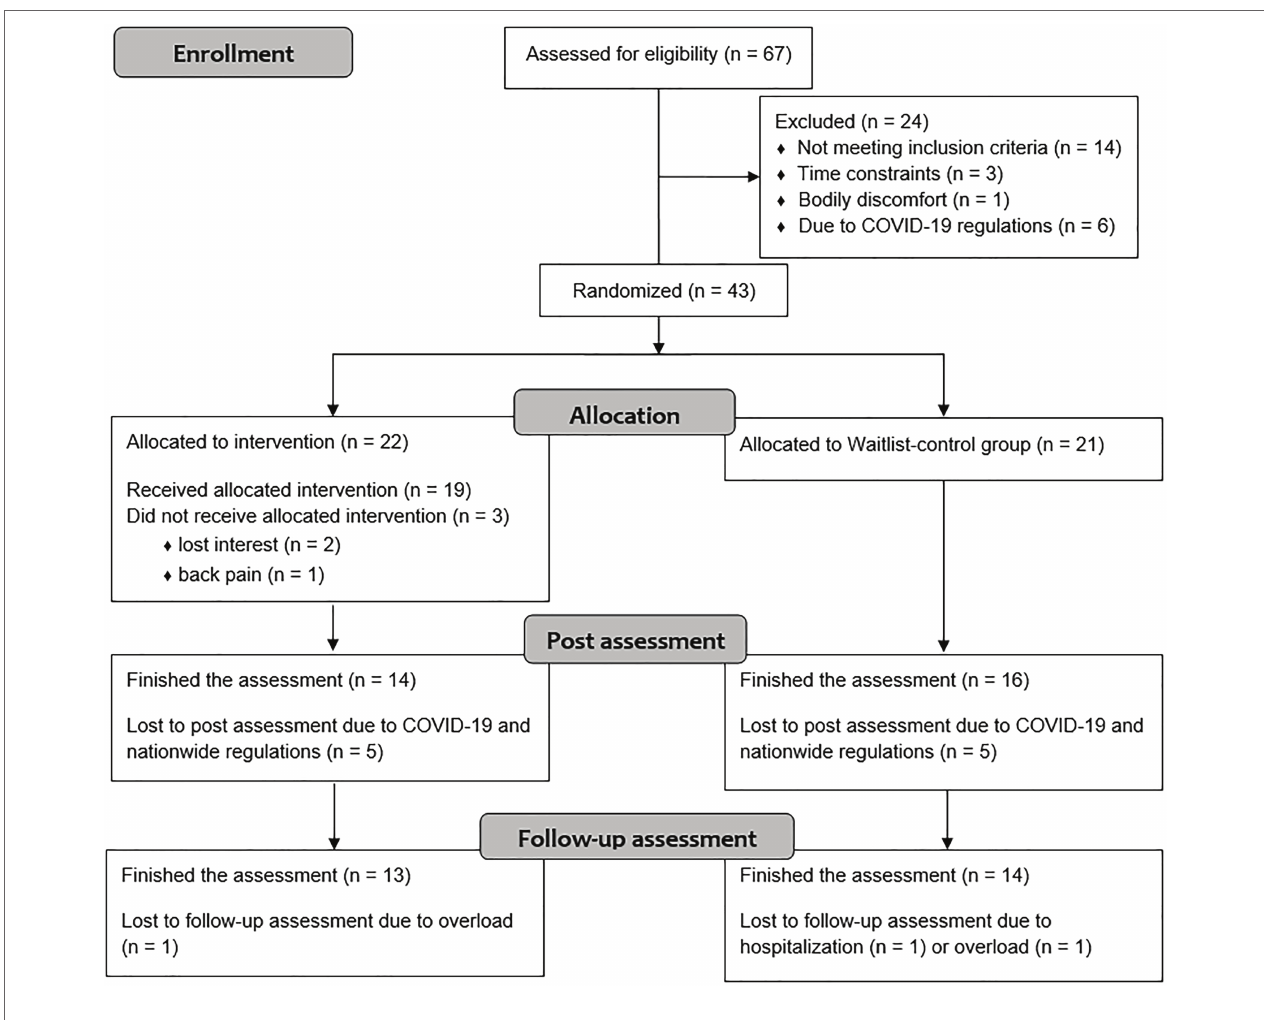
FIGURE 2 | CONSORT diagram.